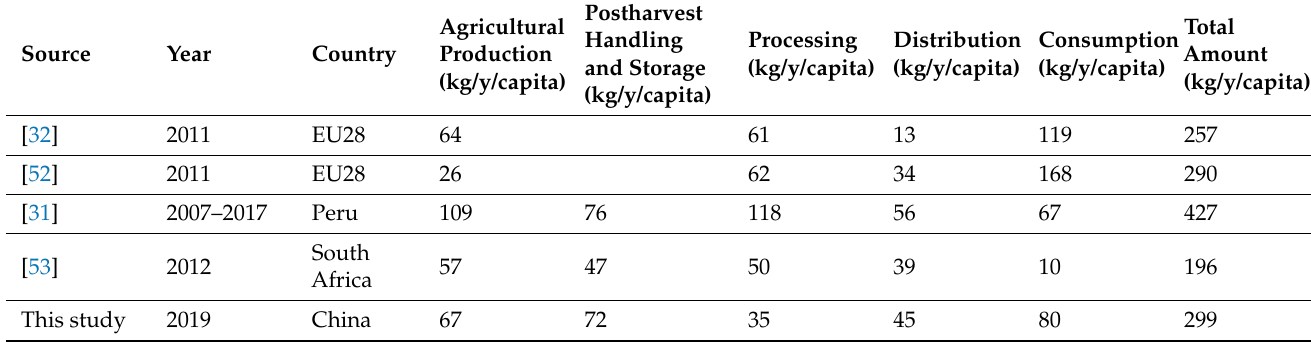
Table 3. Comparison of the FLW obtained in this study with studies in other